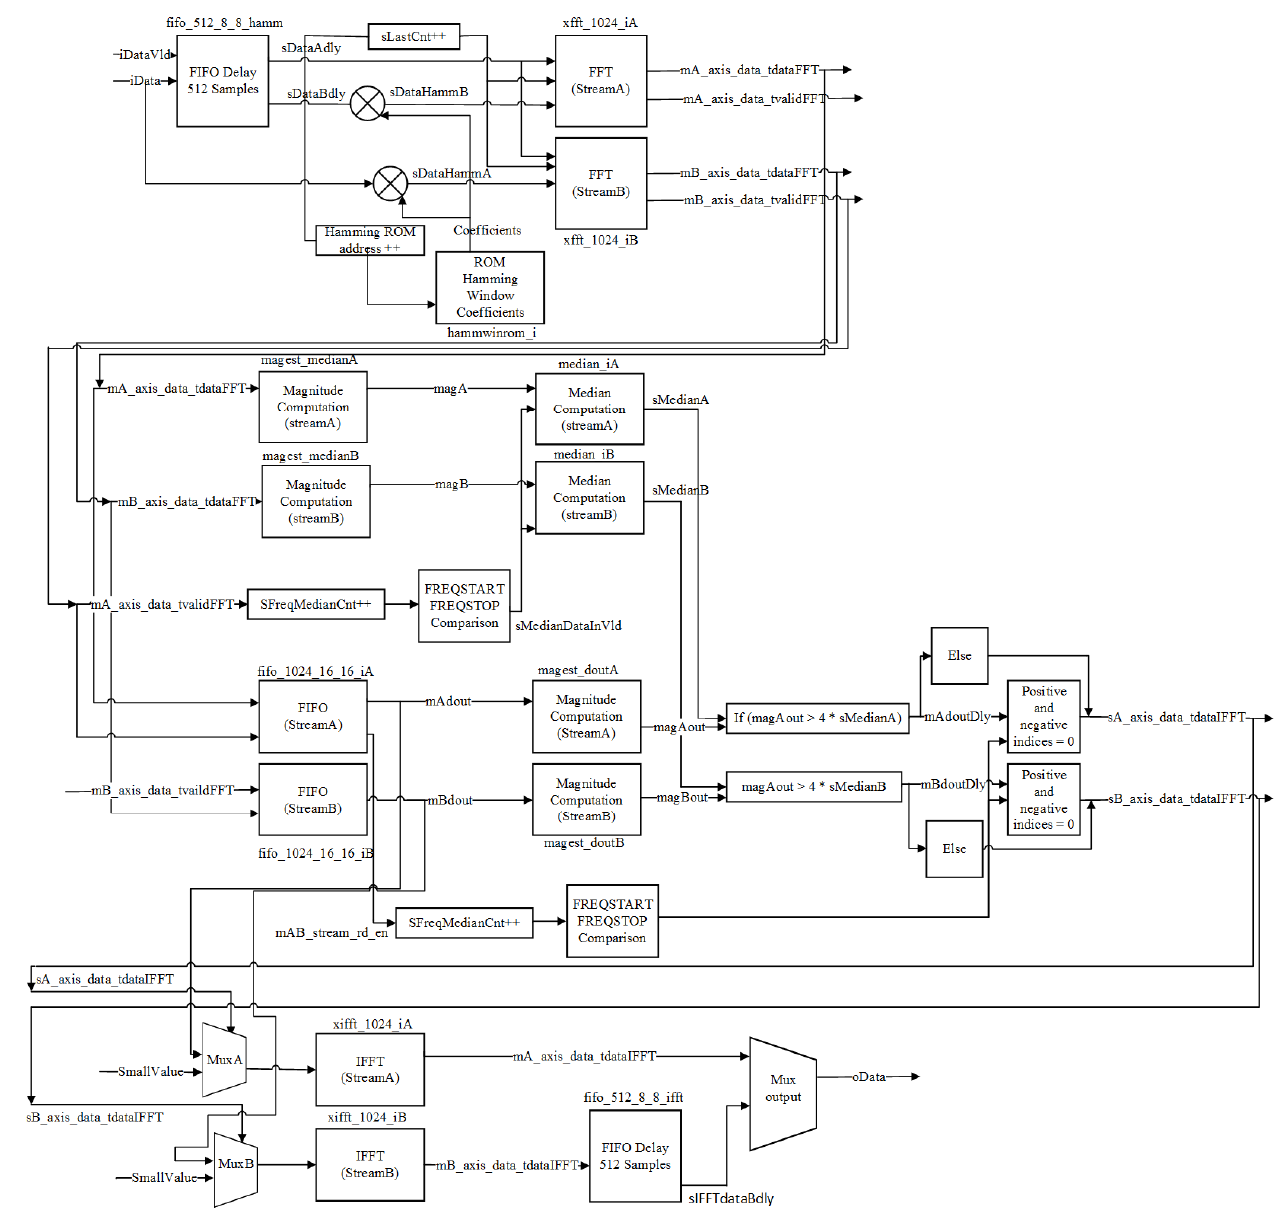
Figure 12. Fixed-point design block diagram .